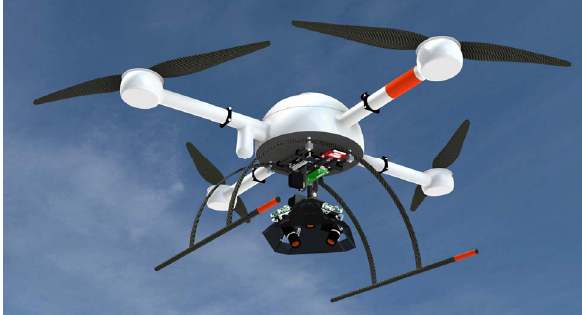
Figure 4: Schematic drawing of the UAV with newly developed multi head camera system "Four